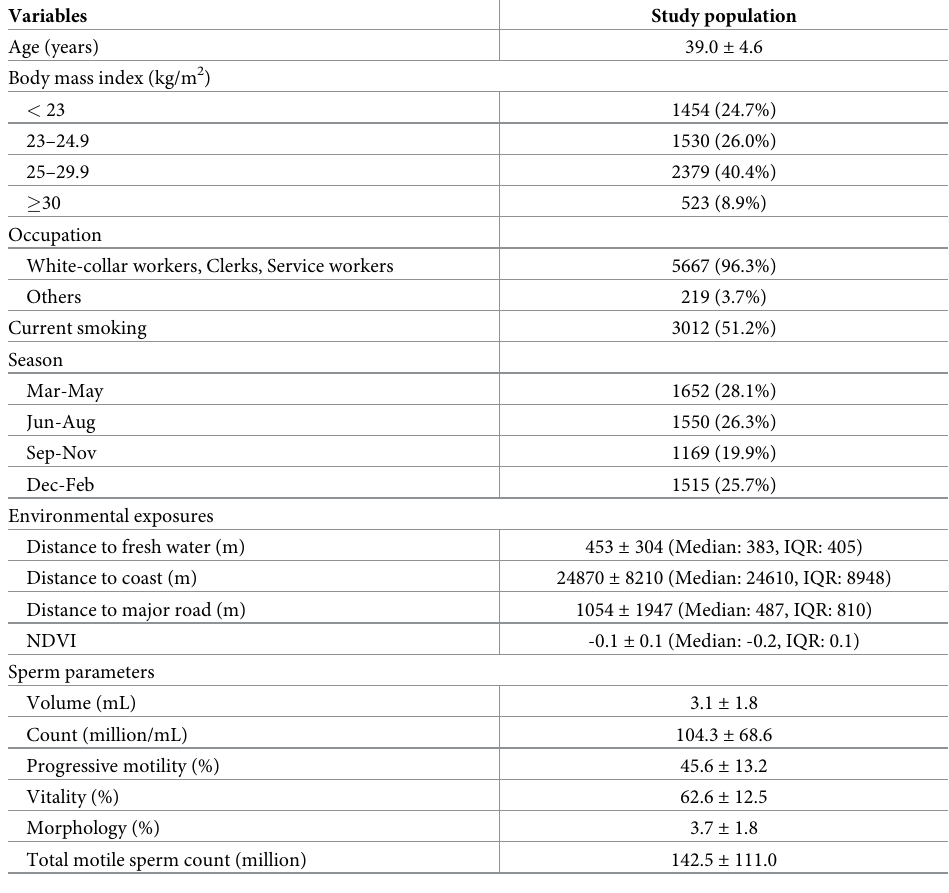
Table 1. Characteristics of 5,886 Korean infertile